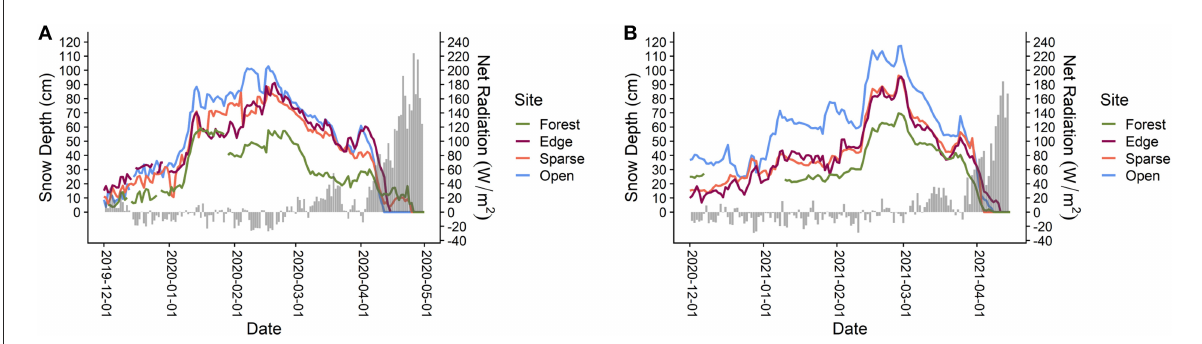
FIGURE4 Snow depth with net total radiation at the LDP location during winter 2020 (A) and winter 2021 (B) . Net total radiation was measured at the weather station located in an open canopy cover site. Note the axis limits are different compared to Figure